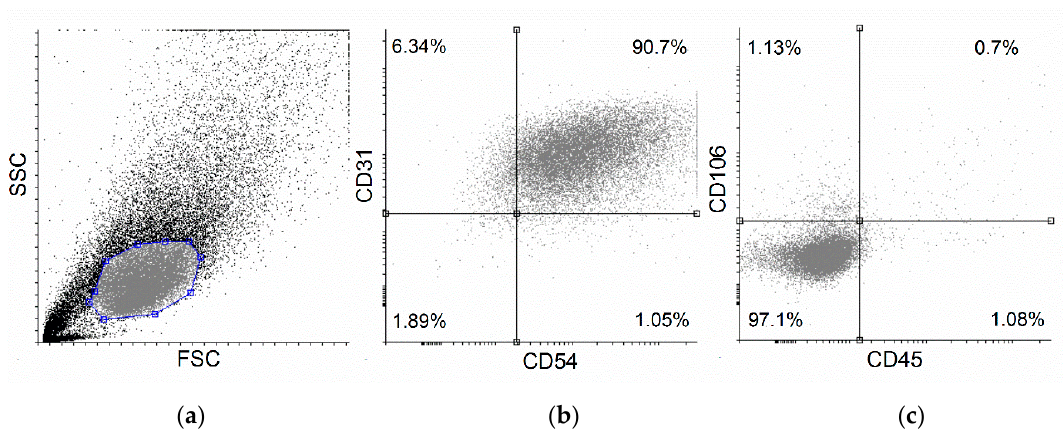
Figure 1. Flow cytometric analysis of human umbilical cord vein endothelial cells (HUVECs). Isolated HUVECs were checked for positive markers ( b ) CD54 and CD31 and negative marker proteins ( c ) CD45 and CD106 expression using specific antibodies. ( a ) Forward- and side-scatter plot and ( b ) dot-plots of HUVEC positive- and ( c ) negative-markers are shown. Representative graph of three independent experiments.